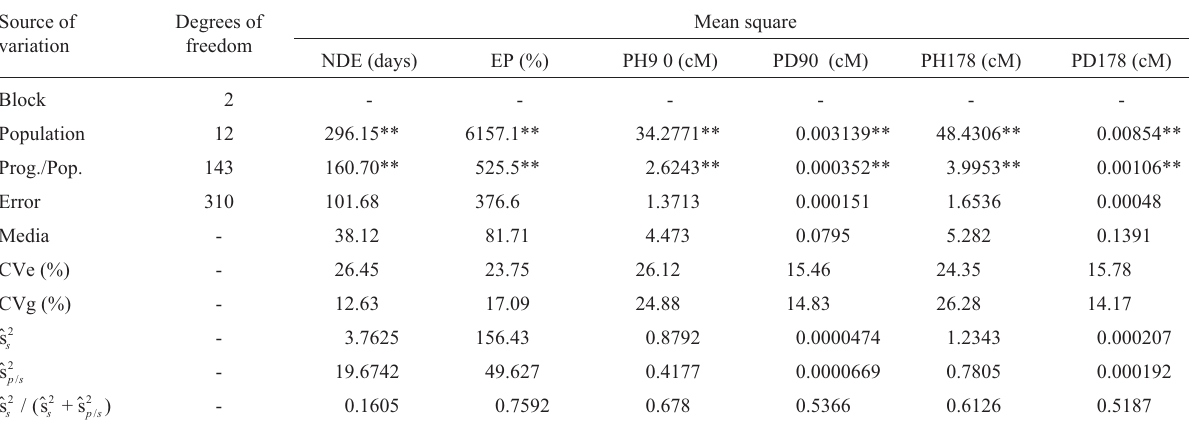
Table 4 - Analysis of variance and estimates of genetic parameters for the traits number of days to emergence (NDE), emergence percentage (EP), plantlet height and plant diameter at 90 (PH90, PD90) and at 178 days (PH178, PD178) after sowing. Source of Degrees of variation